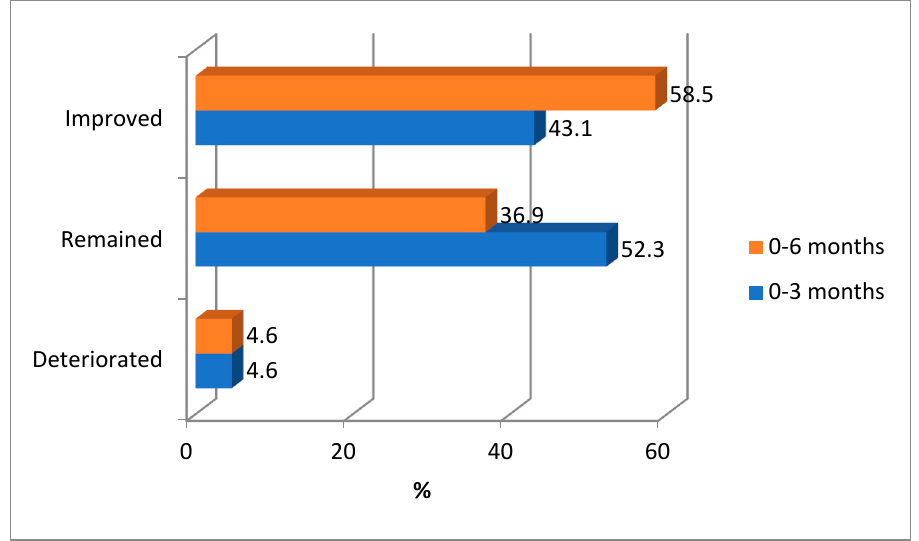
Figure 4. Impact of an education intervention on HbA1c levels at 3 and 6 months of intervention.